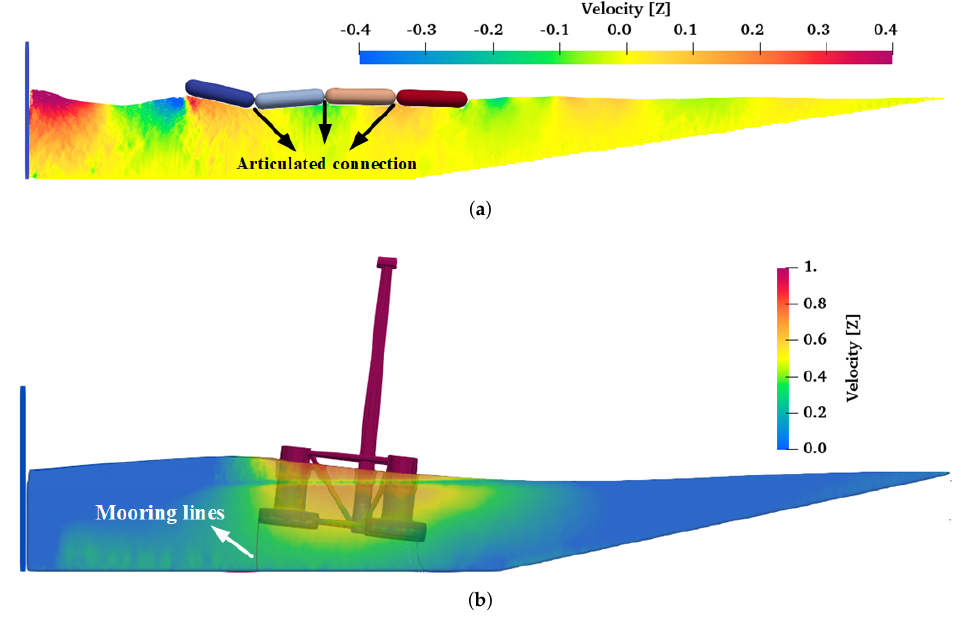
Figure 16. Typical simulation results of the coupling strategy of DualSPHysics [120]. ( a ) Pelamis by “DualSPHysics + Project Chrono.” ( b ) Semi-submersible FWT by “DualSPHysics +